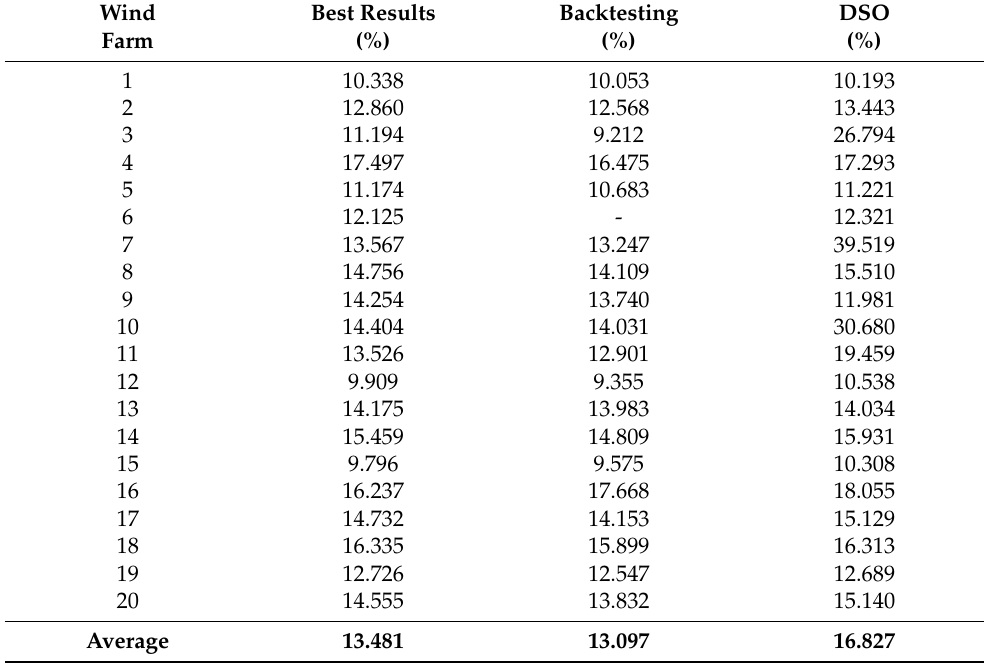
Table 6. RRMSE for XGBOOST using backtesting strategy: 1-year training, 6 months forecast. Wind Best Farm